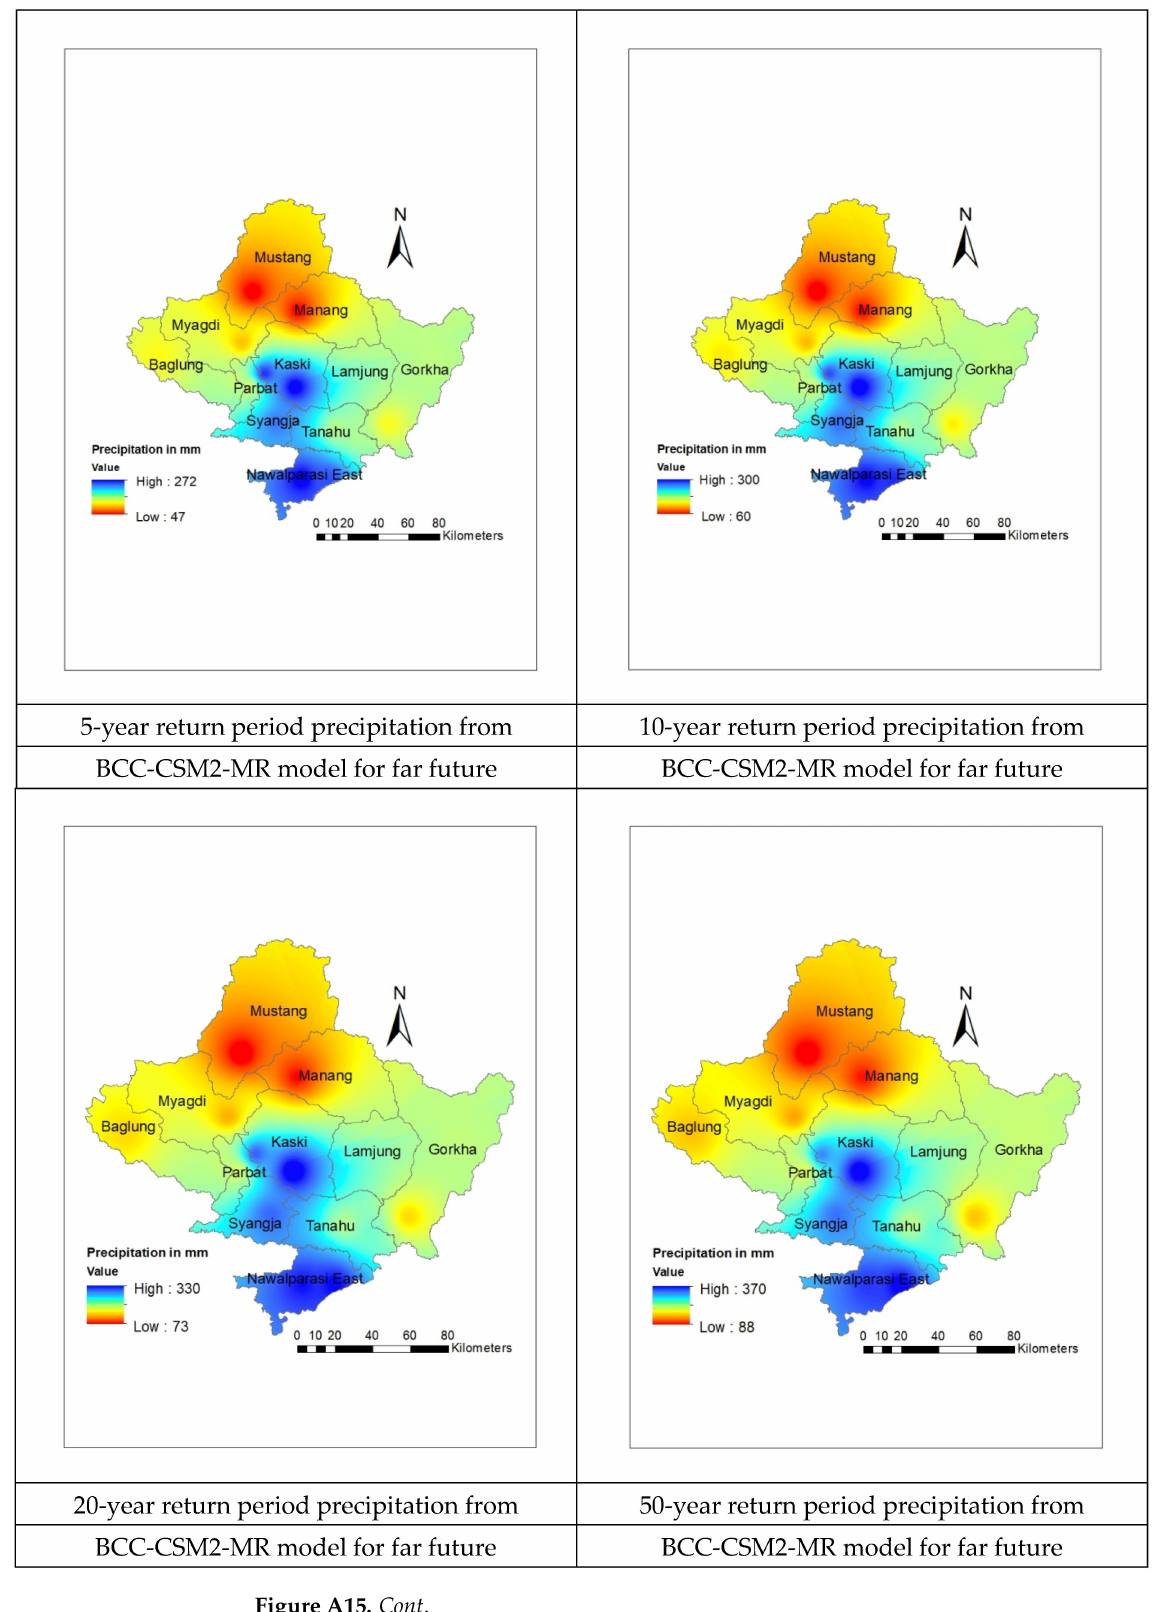
Figure A15. Cont